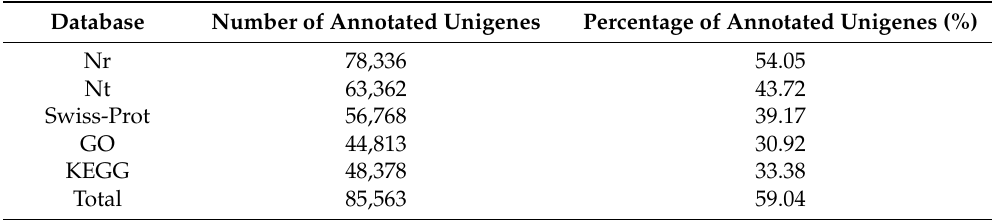
Table 2. Summary of the annotations from public databases. Nr: NCBI nonredundant protein; GO: gene ontology; KEGG: Kyoto Encyclopedia of Genes and